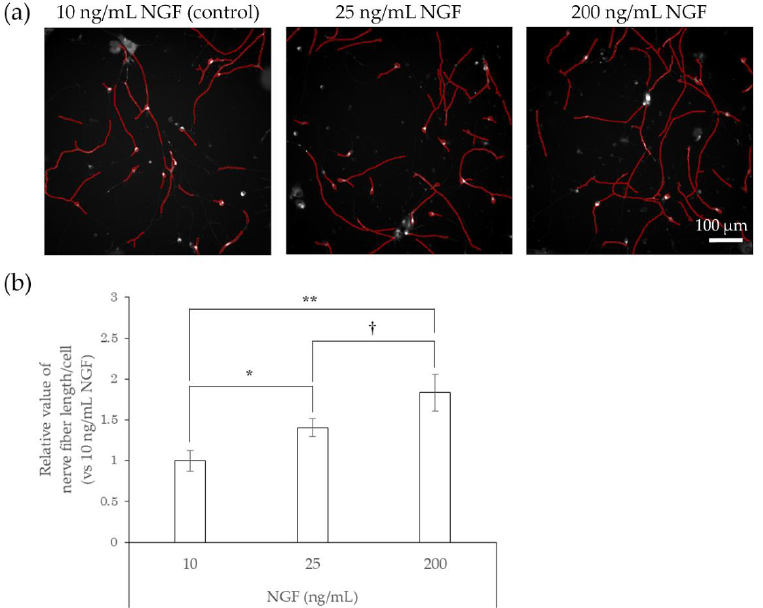
Figure 2. Effects of NGF on nerve fiber elongation of hiPSC-SNs. After culturing for 3 days, hiPSC-SNs were incubated with medium containing NGF for 24 h and stained with NeuO, a neuron-selective probe. ( a ) Representative images with nerve fibers outlined in red were obtained using IN Cell Analyzer 2200. The red lines indicate NeuO-stained nerve fibers. ( b ) Nerve fiber length per cell versus 10 ng/mL NGF after incubation with various doses of NGF. Each value represents the mean of three to four wells. * p < 0.05, ** p < 0.001, vs. 10 ng/mL NGF (Tukey’s test); † p < 0.05, vs. 25 ng/mL NGF (Tukey’s test). NGF: nerve growth